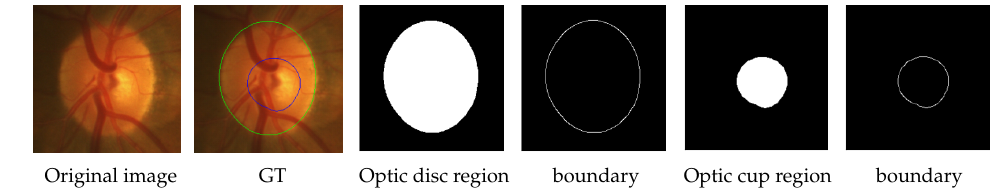
Figure 3. Illustration of the region and boundary of the optic cup and optical disc.